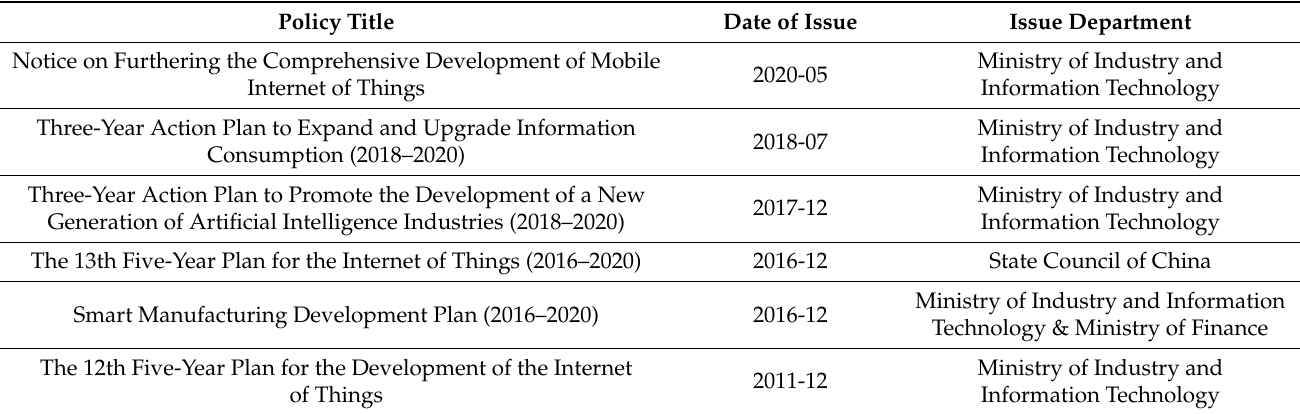
Table 1. List of China IoT Hospitality industry Policy from 2020 to